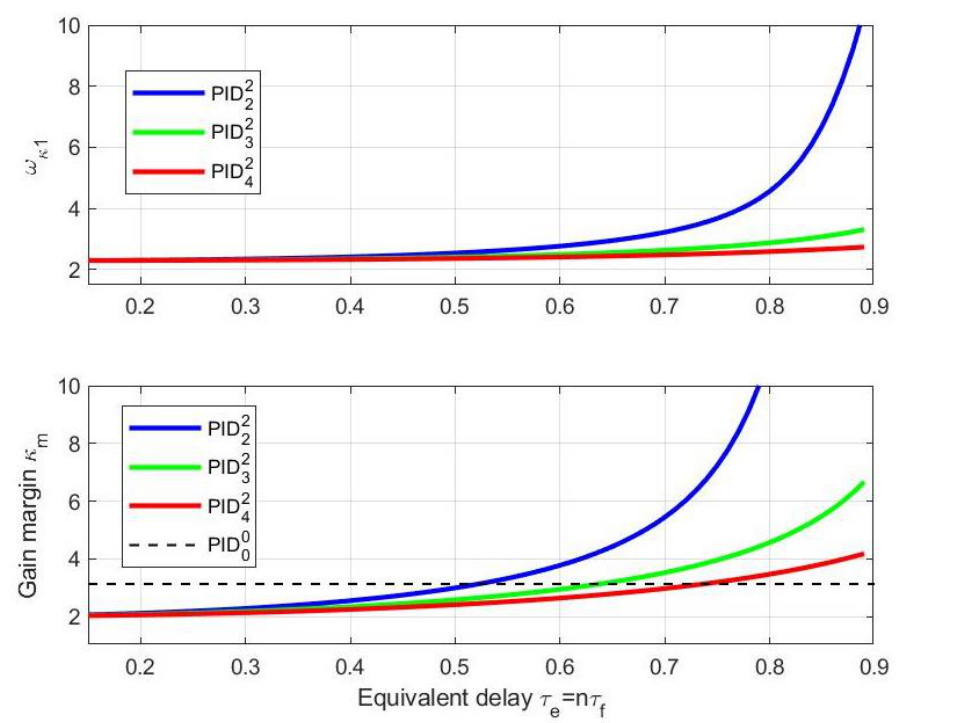
, PID 2 , and PID 2 controllers for 2 3 4